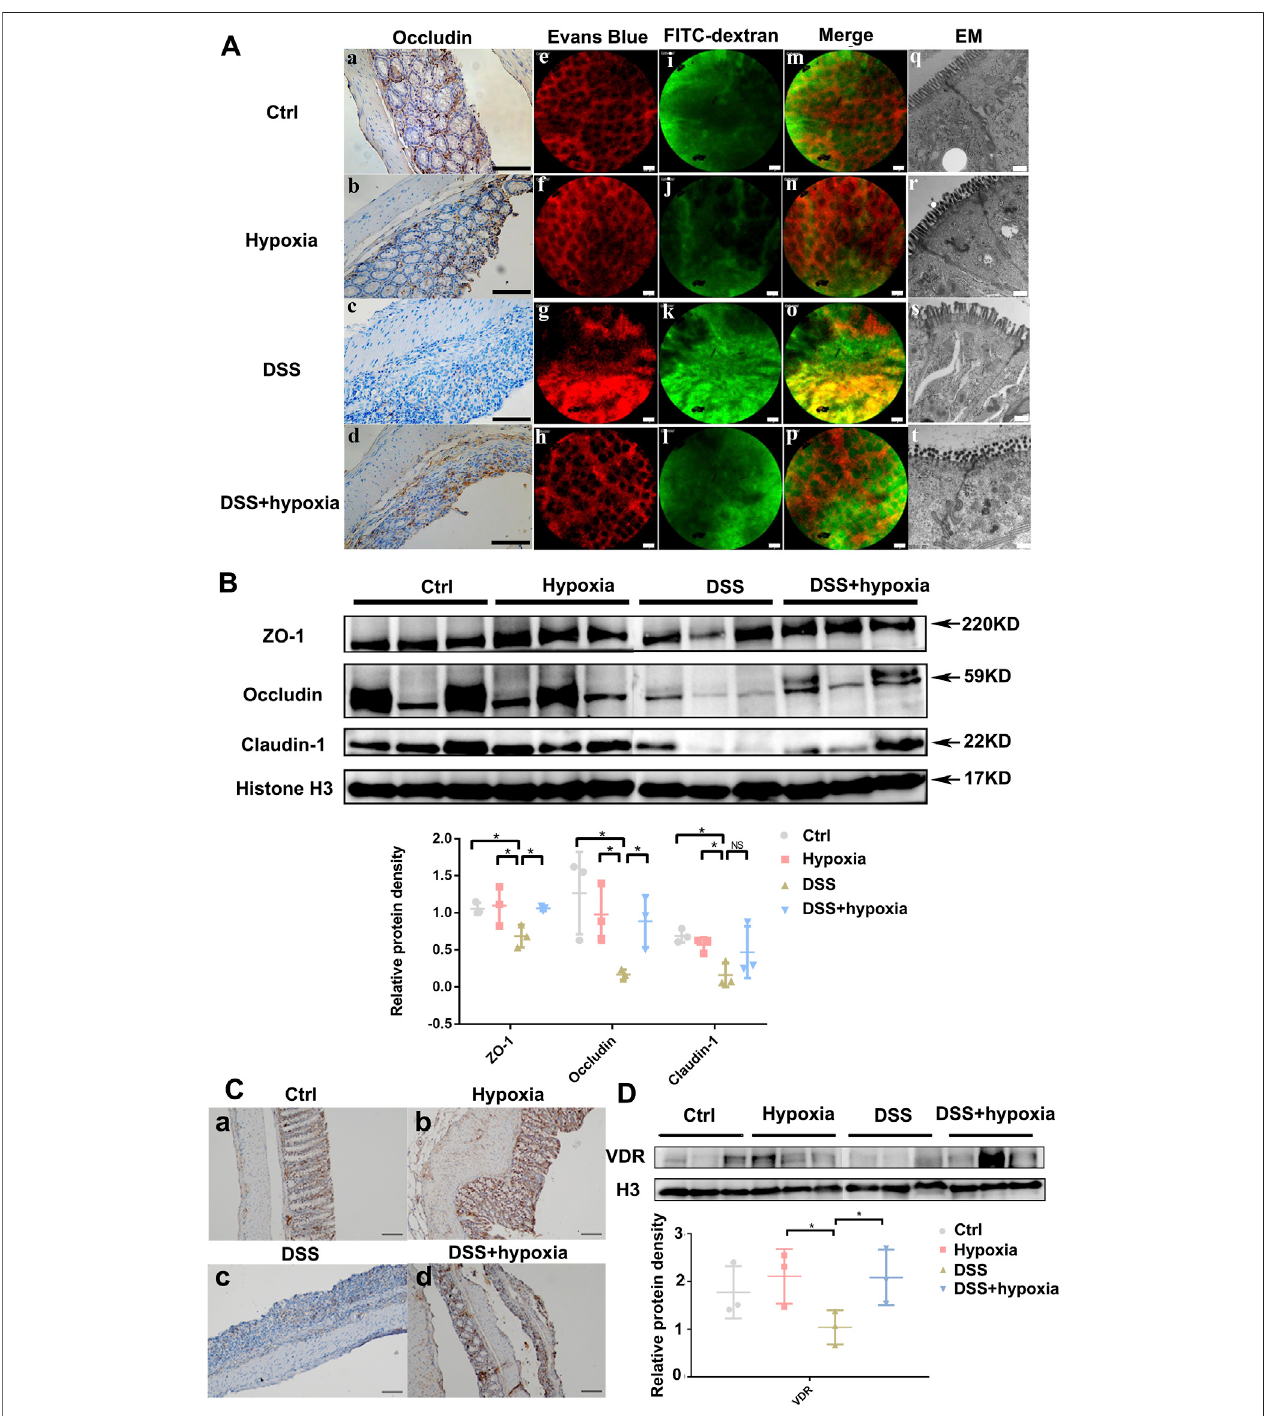
FIGURE2| TheimpactofhypoxiatreatmentontheintestinalmucosalbarrierinmicewithDSS-inducedcolitis. (A) (a – d):Immunohistochemistrystainingofoccludin in each group. Bars = 100 μ m. (A) (e – p): Intravital fl uorescein penetration experiments of the mice intestinal mucosa near the anus in each group. Blood vessels (red) wereblurred,and70 – kDFITC – dextran(green)wasvisibleintheimpairedintestinalmucosaintheDSSgroup[ (A) .g,k,ando],whichwasimprovedintheDSS+hypoxia group [ (A) . h, l, and p]. Bars = 50 μ m. (A) (q – t): The tight junction structure under electron microscope of each group. Bars = 500 nm. (B) : Tight junction protein expression (including ZO-1, occludin and claudin-1) by Western blotting in each group. (C) (a-d): Representative pictures of VDR protein expression by immunohistochemistry in each group. Bars = 100 μ m. (D) : VDR protein expression by Western blotting analysis in each group. All experiments were repeated three